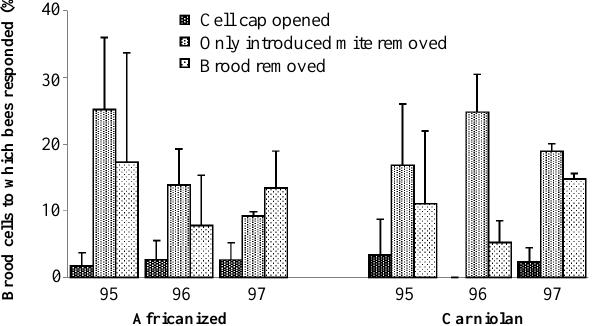
Figure 3 - Components of hygienic behavior in Africanized and Carniolan colonies (for summarized results see Figure 2). Mite removal is the pre- dominant response to artificially mite-infested brood cells in both bee